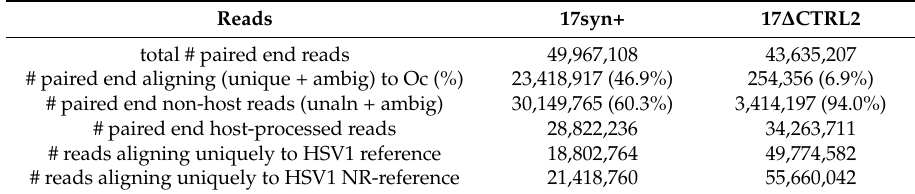
Table 1. Illumina sequencing and processing. The HSV1 reference (GenBank Accession Number: NC_001806) was used intact and then reduced to only non-redundant (NR) where each repetitive region was included only once in the reference. The coordinates for the NR-reference are in Supplementary File 5.